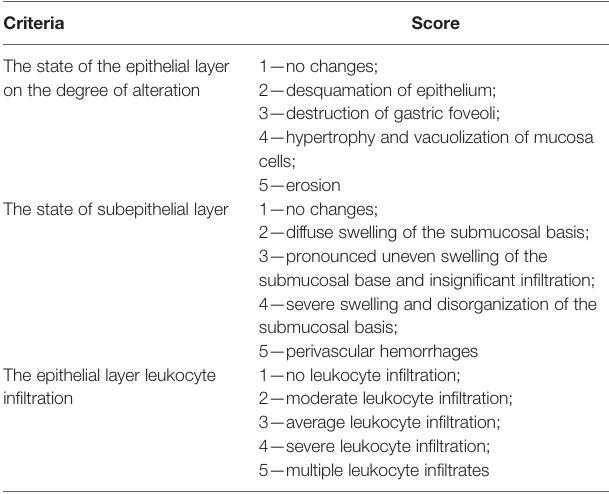
TABLE 1 | Criteria used for semi-quantitative analysis of gastric mucosa